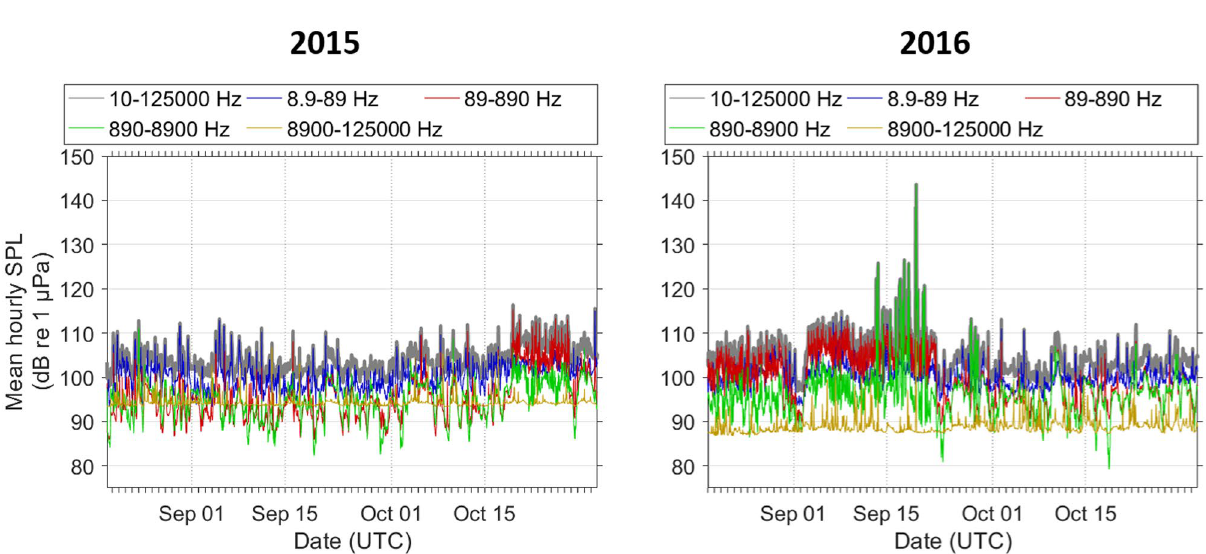
Figure 5. Mean hourly frequency band ambient sound pressure levels (SPL) recorded in 2015 and 2016 from August 19th to October